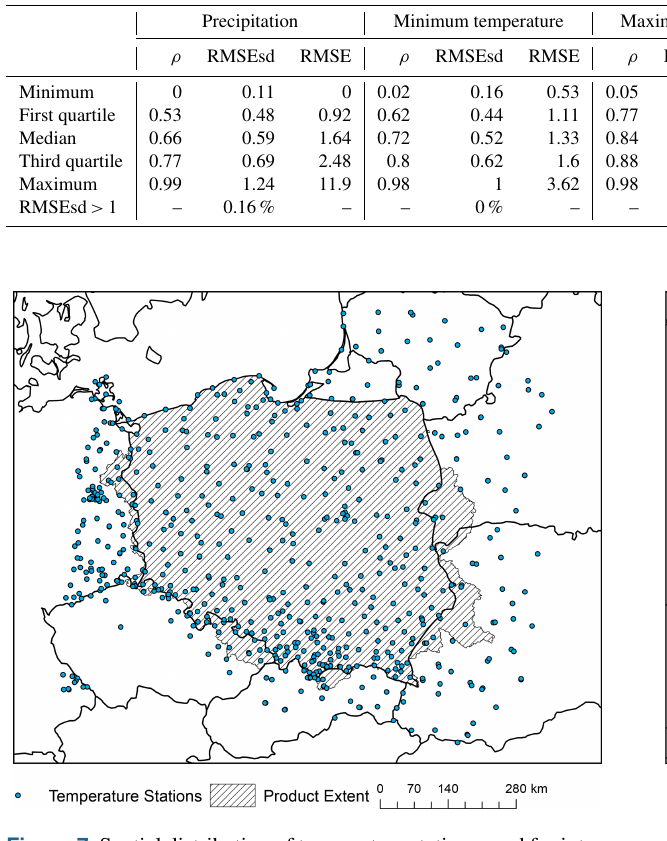
Figure 7. Spatial distribution of temperature stations used for inter- polation of the G2DC-PL + product. Figure 8. Spatial distribution of relative humidity stations used for interpolation of the G2DC-PL +